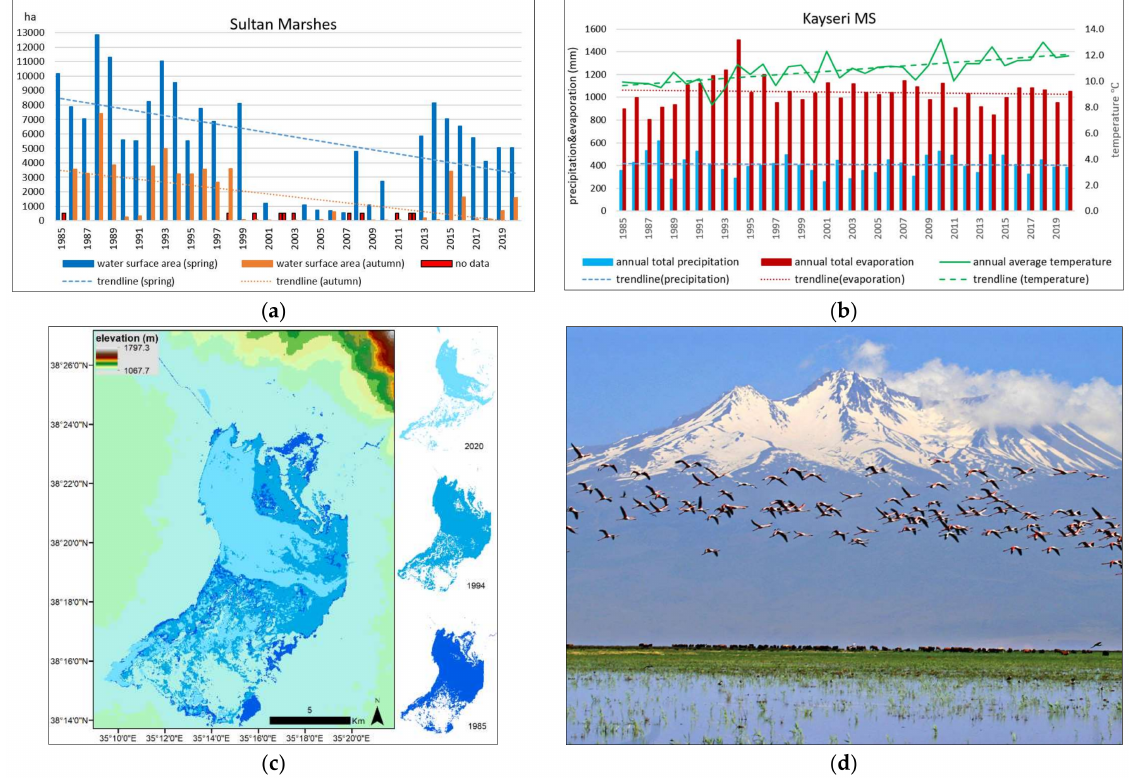
Figure 12. Sultan Marshes: ( a ) 1985–2020 annual (spring and autumn) surface water areas; ( b ) representative meteorological station data (precipitation, evaporation, and temperature); ( c ) water surface area changes (NDWI); ( d ) view of the site